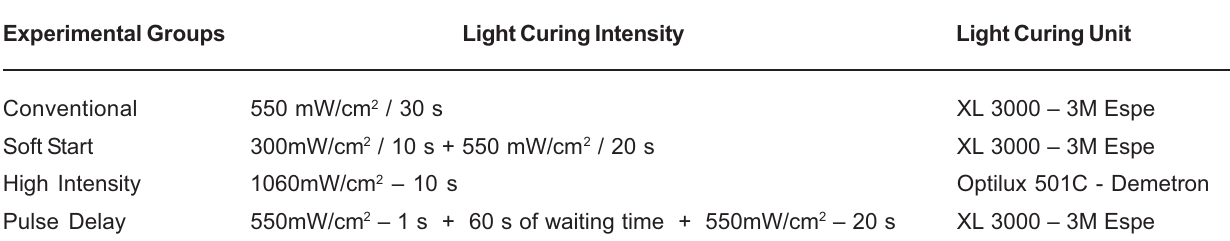
TABLE 1- Experimental groups (light curing